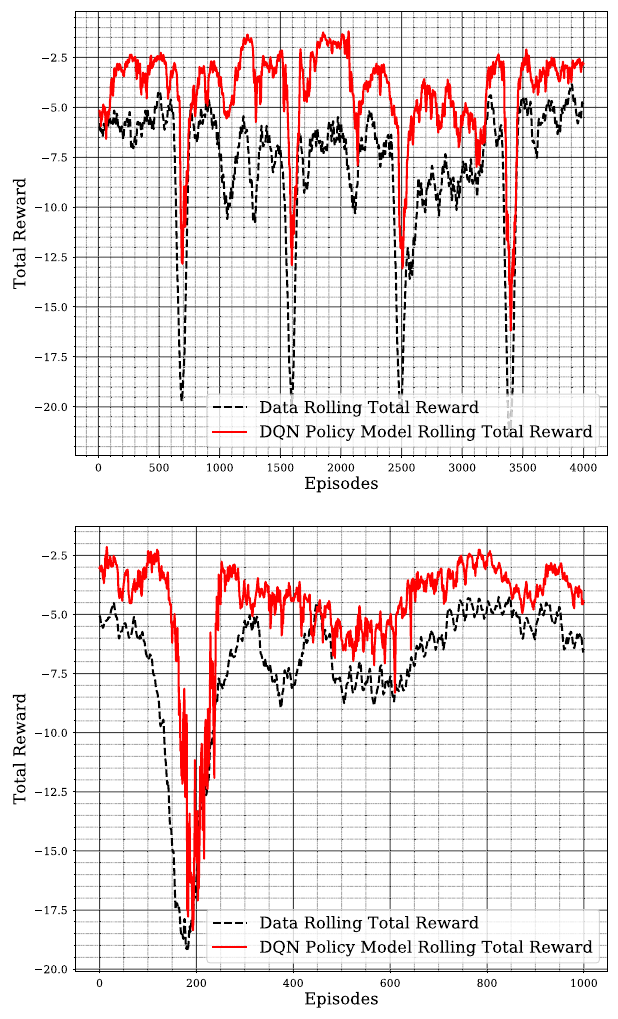
FIG. 7. Top: Total rolling reward per episode versus number of training episodes for the DQN MLP algorithm (solid red line) at top. During training, the ten-episode rolling window determines the first entry at the tenth episode on the plot. Bottom: The corresponding testing results (without a rolling average) are shown